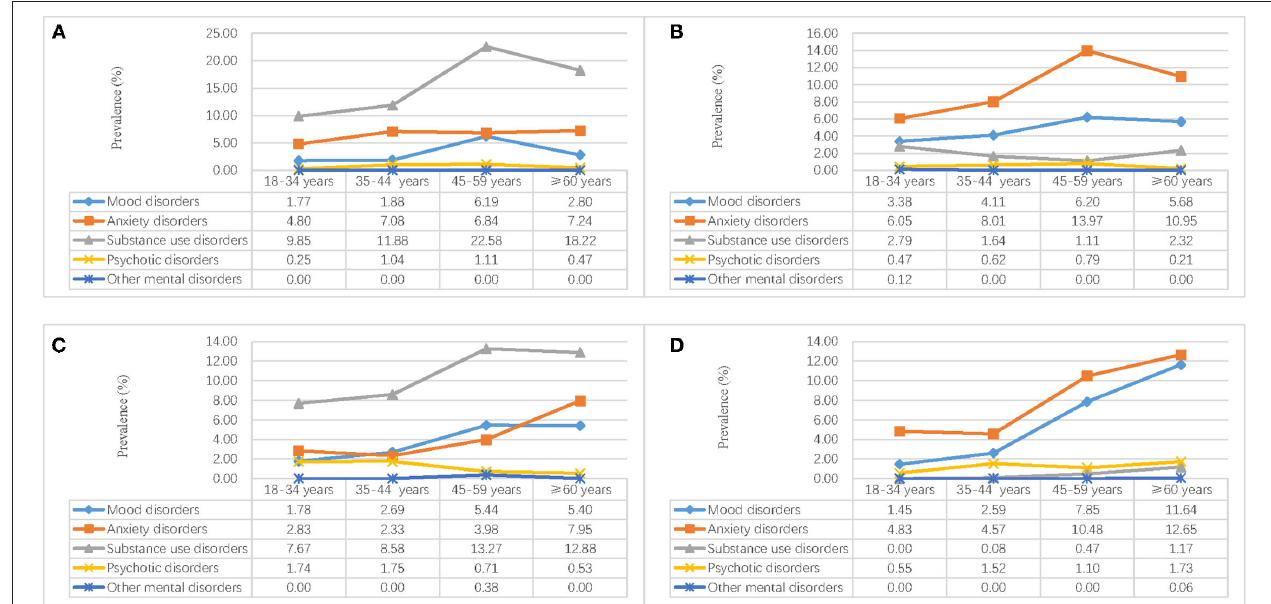
FIGURE 2 | Weighted region-gender-age-specific lifetime prevalence of mental disorders in Hebei province, China. (A) Urban male; (B) Urban female; (C) Rural male; (D) Rural female.